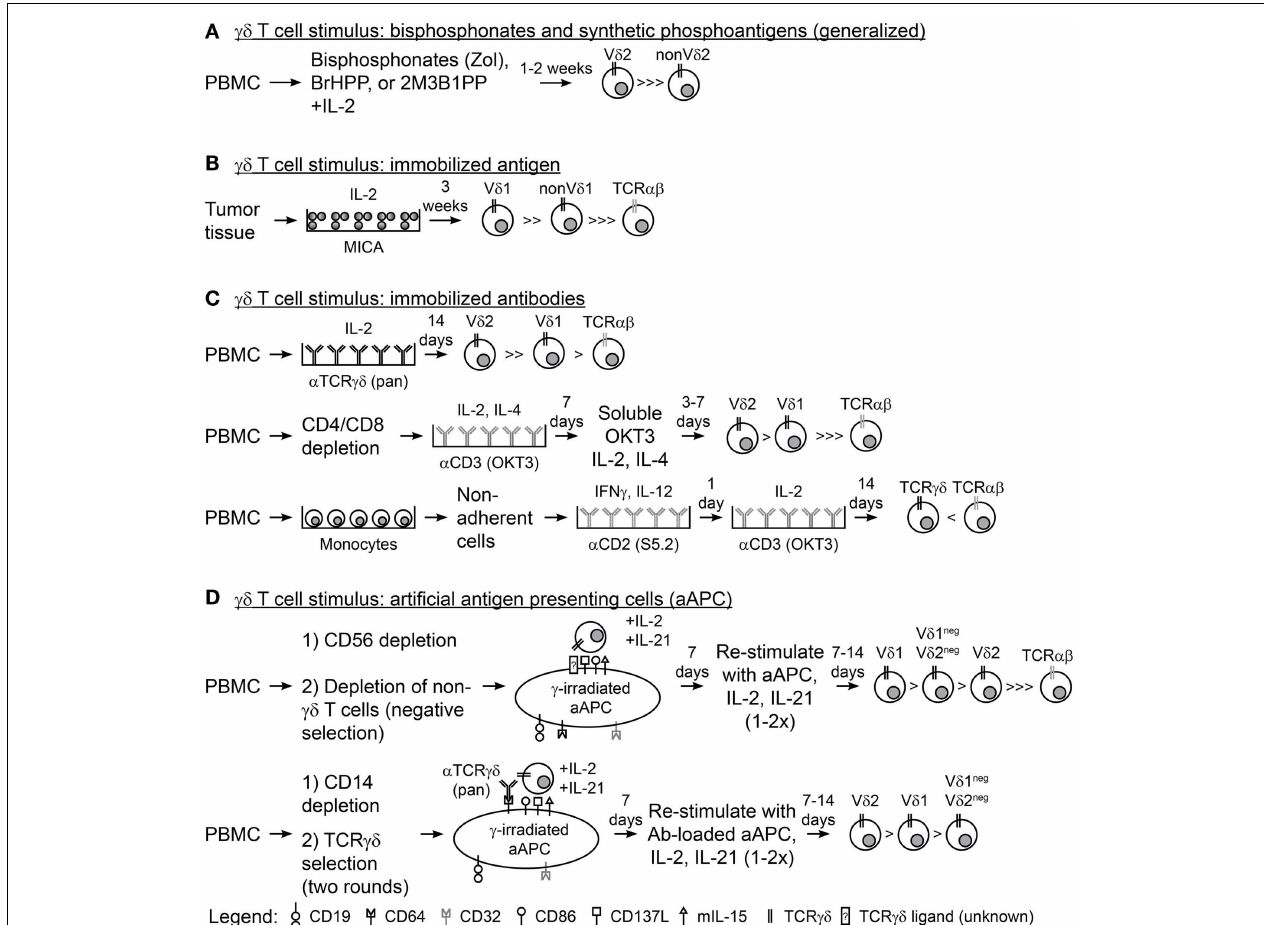
and IL-4, and (bottom) PBMC were depleted of non-adherent cells, stimulated with anti-CD2 Ab (S5.2), interferon- γ (IFN γ ), and IL-12,